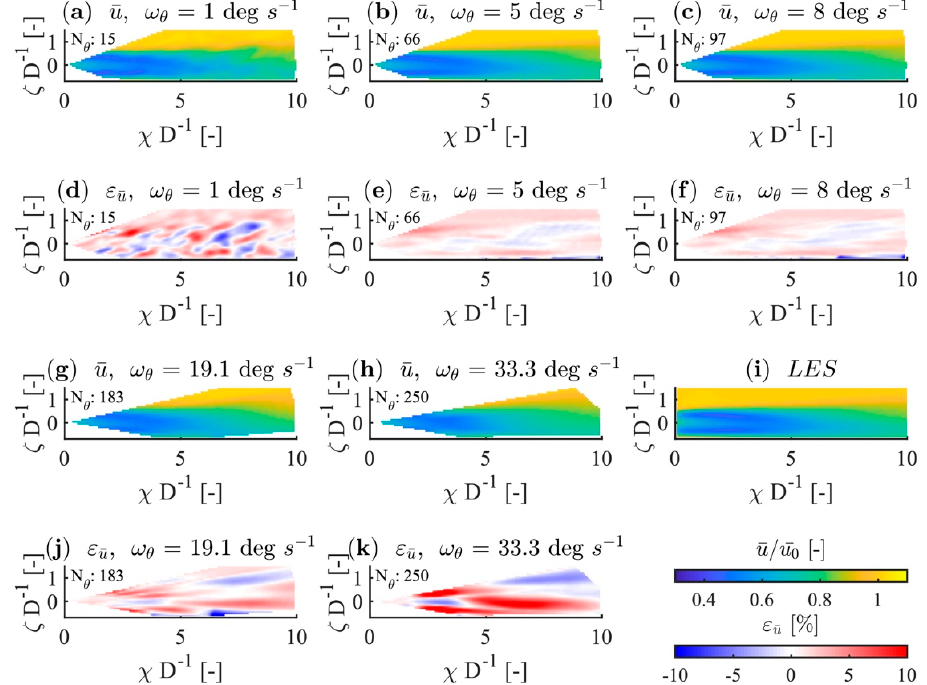
Figure A1. Visualisation of the normalised 10-min averaged wind-speed component u of the original RHI data and ( d – f ) and ( j – k ) the corresponding flow deviations, ε u , from ( i ) the normalised 10-min averaged wind-speed component, u , of LES data. Remote Sens. 2019 , 11 , x; FOR PEER REVIEW 26 of 31